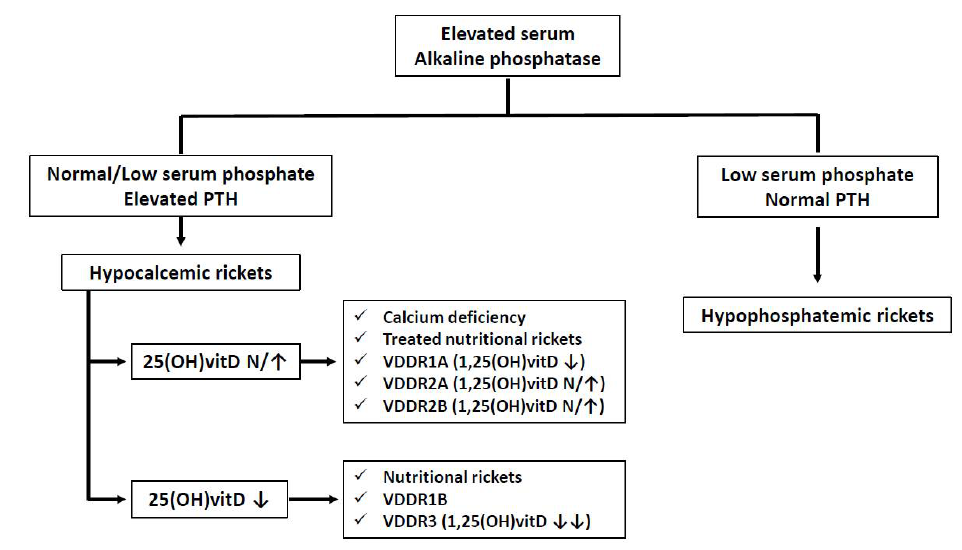
Figure 2. Diagnostic algorithm of the different forms of rickets.